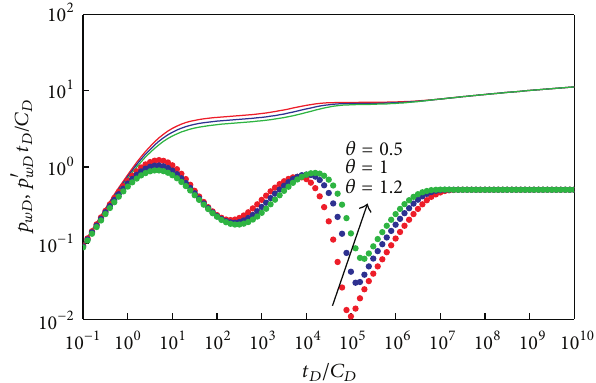
Figure 6: Effect of branch angle ( 𝜃 ) on type curves ( 𝛼 = 1 , 𝛽 = 0.707 , 𝑁 = 4 , 𝑀 = 10 , 𝑙 = 0.1 m, 𝑆 = −1 , 𝐶 𝑟 𝑤 and 𝐶 𝑓𝑡 = 1 × 10 −4 MPa −1 ).